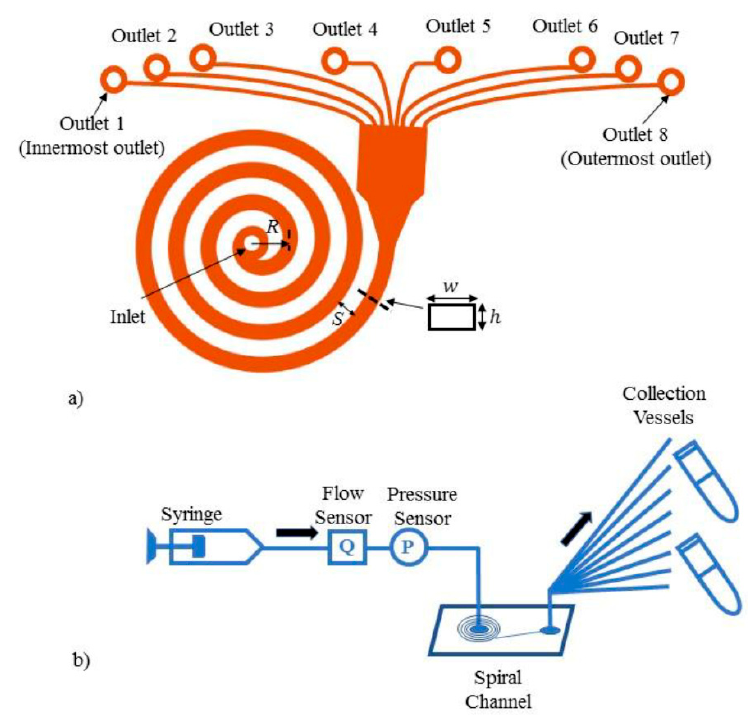
Figure 1. ( a ) Overhead view depicting the spiral microchannel flow model with 8 outlets, and ( b ) the easily reproducible test setup for the particle separation tests.